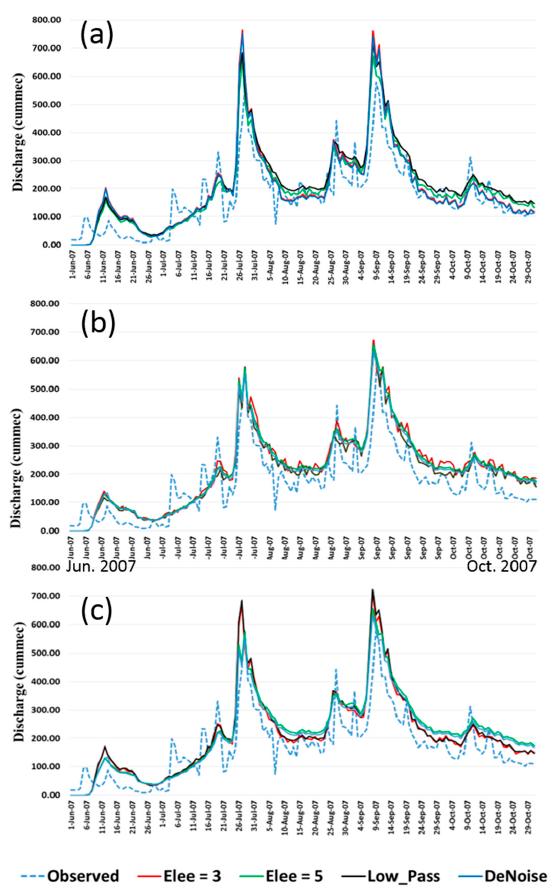
Figure 9. Sensitivity to smoothing in ( a ) SRTM DEM. ( b ) ASTER DEM, and ( c ) CARTO DEM based on the discharge at the outlet.